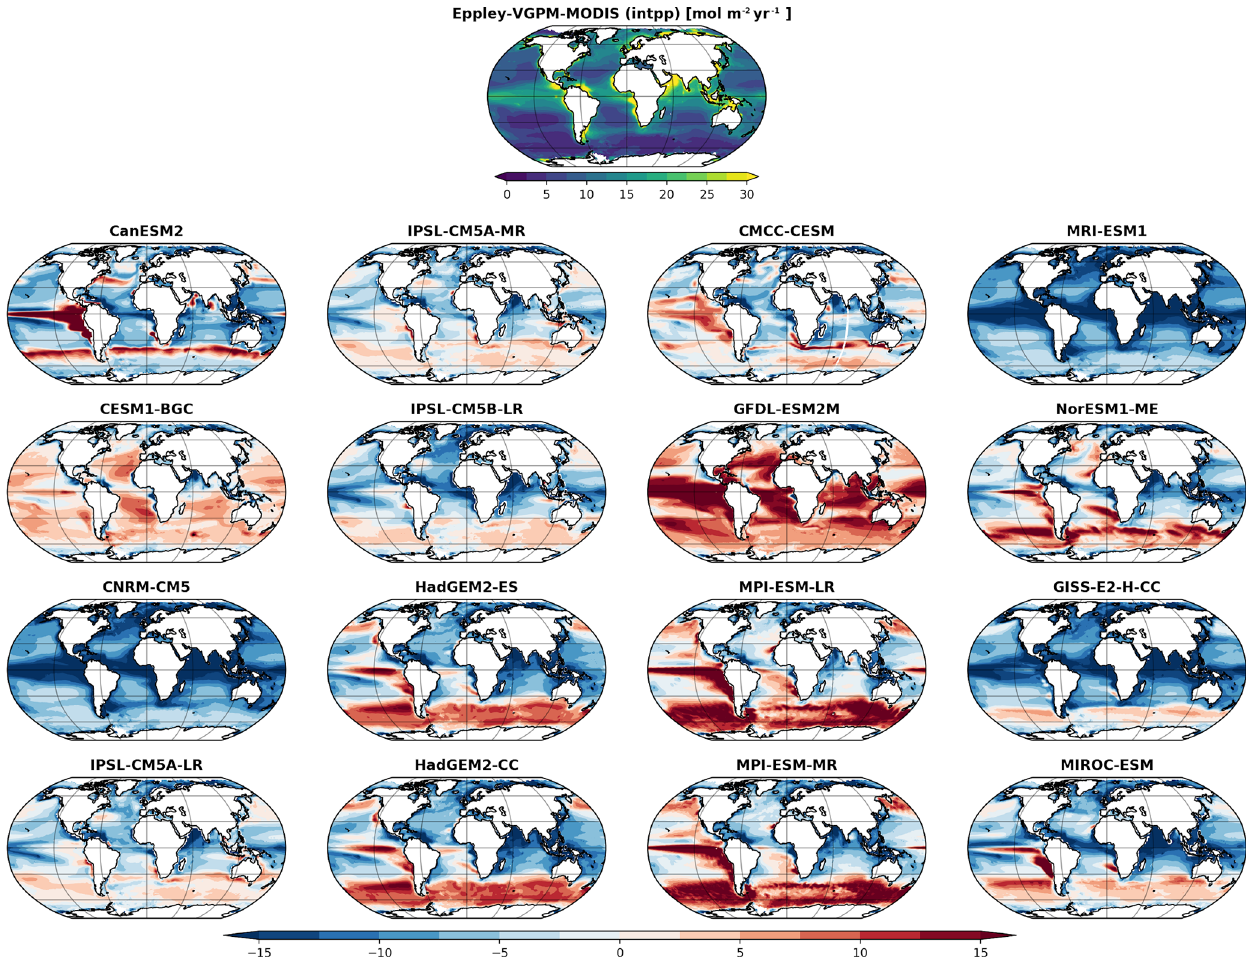
Figure 41. Global maps of marine primary production as carbon (molm − 2 yr − 1 ) estimated from MODIS satellite data using the Eppley VGPM algorithm (top panel) and differences computed for 16 CMIP5 models with data averaged over the period 1995–2004. See Sect. 3.5.3 for details on recipe_ocean_bgc.yml